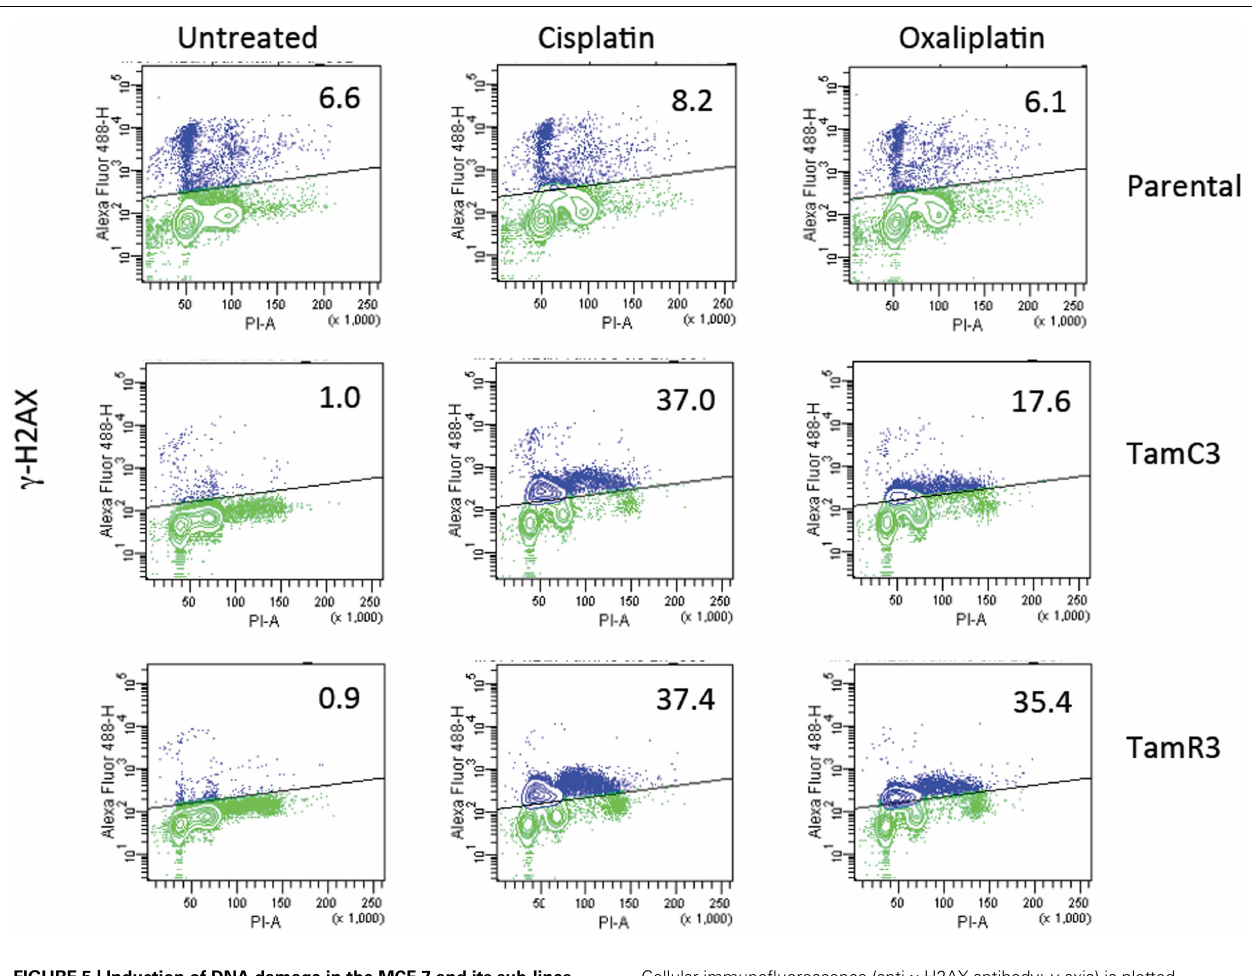
FIGURE 5 | Induction of DNA damage in the MCF-7 and its sub-lines . Induction of γ -H2AX phosphorylation following exposure to cisplatin or oxaliplatin for 2h. MCF-7 parental and derivedTamC3 andTamR3 sub-lines were either untreated or exposed cisplatin (50 µ M) or oxaliplatin (50 µ M) then fixed, stained, and assessed by flow cytometry for γ -H2AX staining.